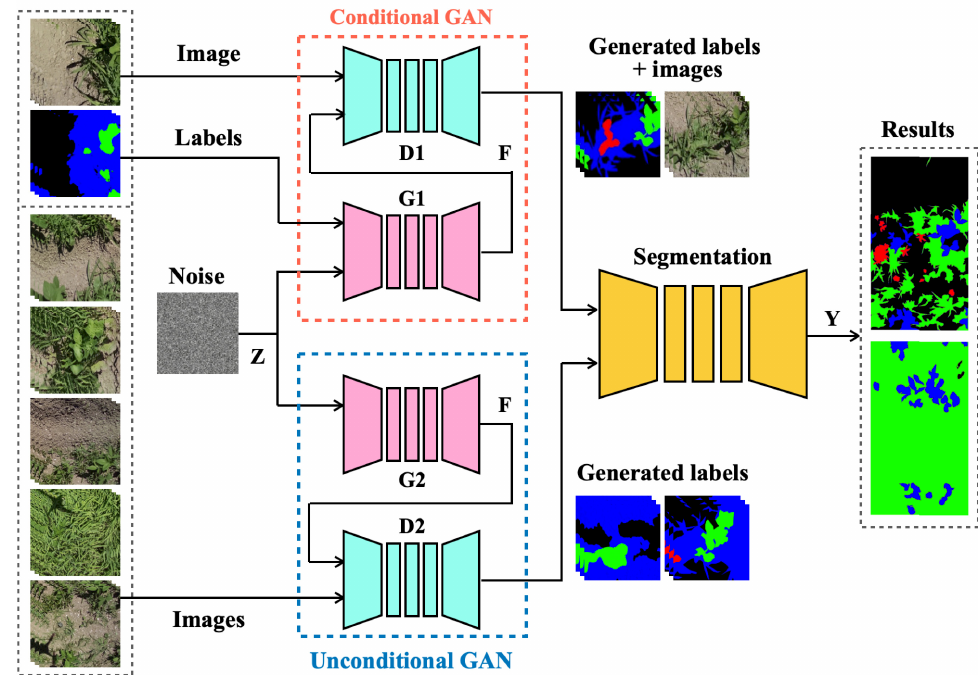
Figure 1. Overall network architecture of the proposed framework consisting of three